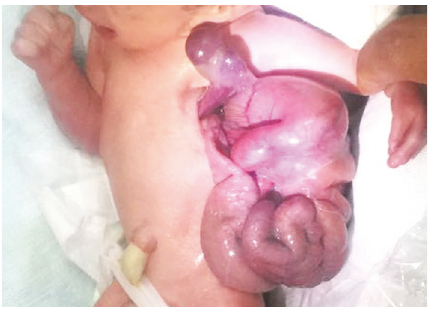
Figure 3: Visceral herniation.